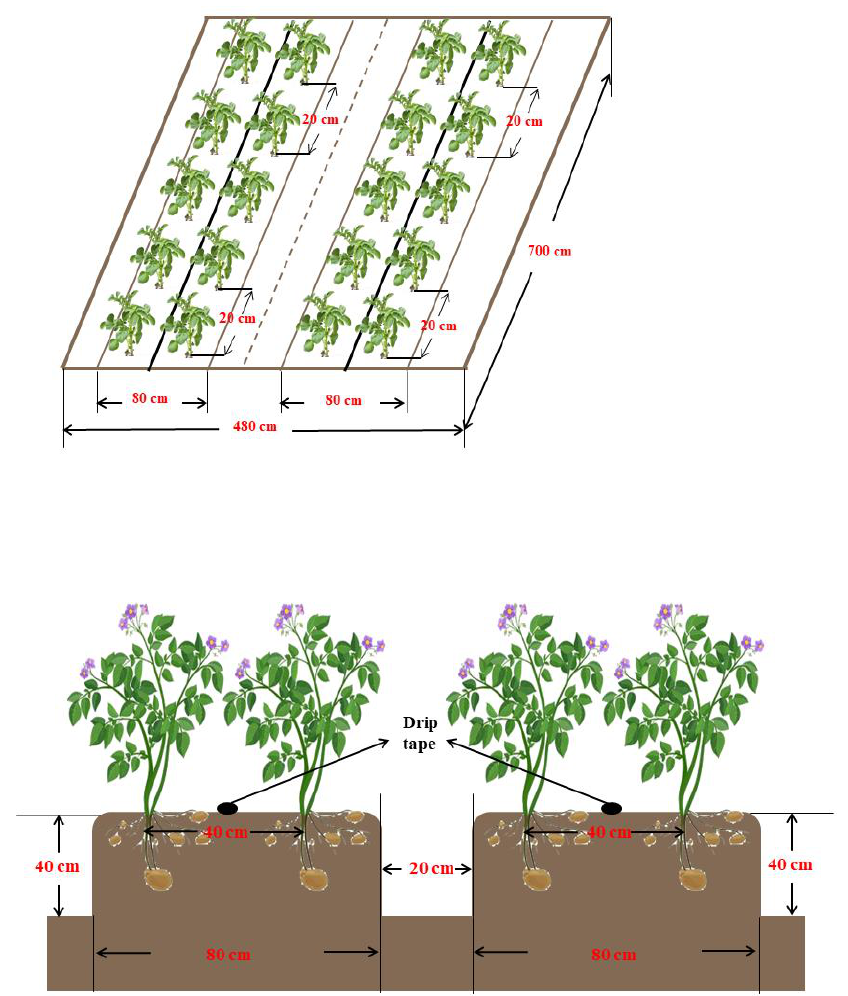
Figure 1. Cultivation of potatoes with regulated deficit drip irrigation on ridges under plastic film mulching.